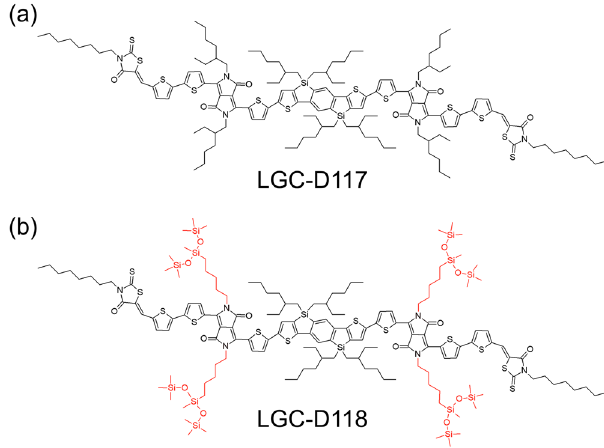
Figure 1. Molecular structures of LGC-D117 and